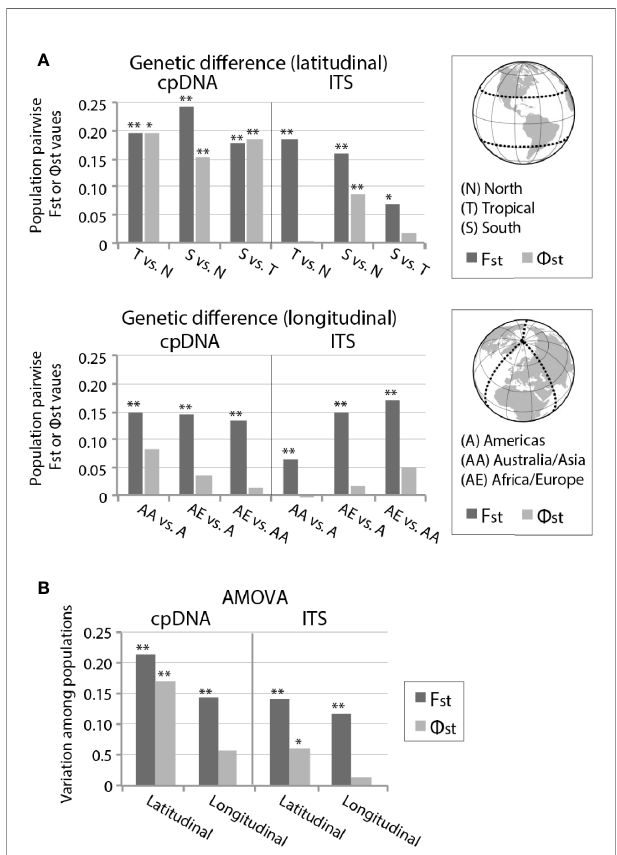
FIGURE 4 | (A) Pairwise F ST and F ST values and (B) analysis of molecular variance (AMOVA) within Ceratodon purpureus populations based on latitudinal and longitudinal geographically divided areas, including samples from the “ concatenated cpDNA ” and GBLOCKS fi ltered ITS data set. For details see Tables S3 – S5 . For geographically divided areas see legend in (A) . P-values are represented by * for P < 0.05 and ** for P <